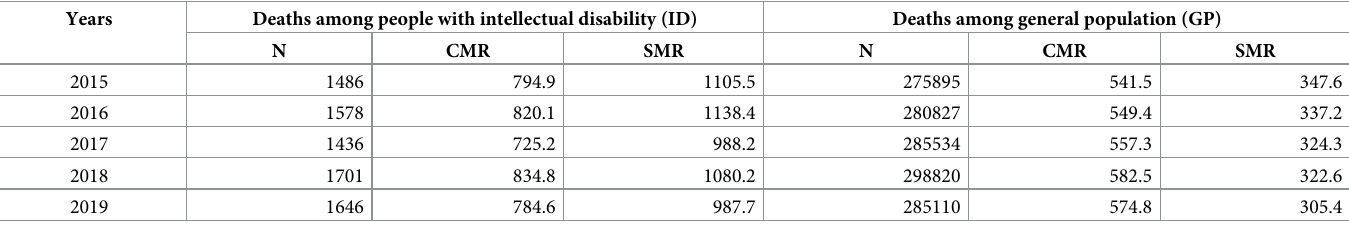
the general population. Among the major causes of death for people with ID, circulatory dis- ease ranked first in the top five causes for the past five years, but the top second and third causes showed a change. Most of the causes of death in people with ID had a higher mortality rate than that in the general population. However, in the case of neoplasms, the general population had a higher mortality rate than people with ID. The SMRs for all causes of death were higher in people with ID than in the general population. In addition, while the general population showed a cer- tain pattern in which most causes of death increased or decreased, most of the causes of death in people with ID showed an irregular pattern. Among the causes of death in people with ID, only digestive diseases (K00-K93) showed a decreasing pattern of mortality. Among the causes of death, congenital anomalies, deformities, and chromosomal abnor- malities (Q00-Q99) showed the largest difference. The difference in mortality rates was more than 20 times between people with ID and the general population, followed by diseases of blood and hematopoietic organs and immune mechanisms. The next rankings were specific disorders (D50-D89); neurological diseases (G00-G99); skin and subcutaneous tissue diseases (L00-L99); and pregnancy, childbirth, and postpartum (O00-O99). Table 2. Mortality and mortality rates of people with intellectual disabilities and the general population from 2015 to 2019. Years Deaths among people with intellectual disability (ID) Deaths among general population